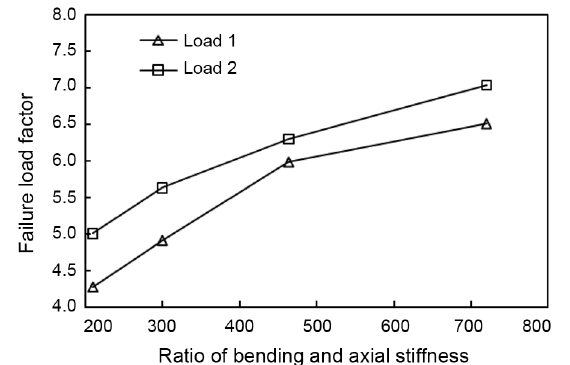
Fig. 14. Failure loads with different ratios of bending and axial stiffness